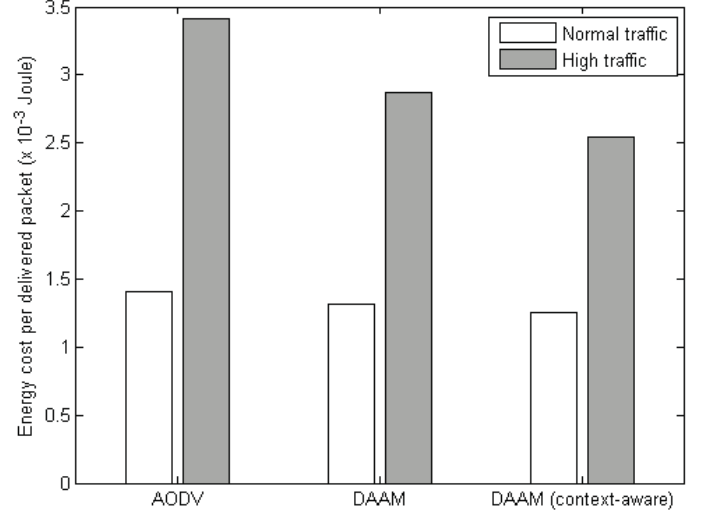
Figure 13. Energy cost for a successful packet delivery of NET